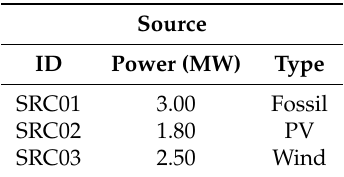
Table 1. Microgrid Power